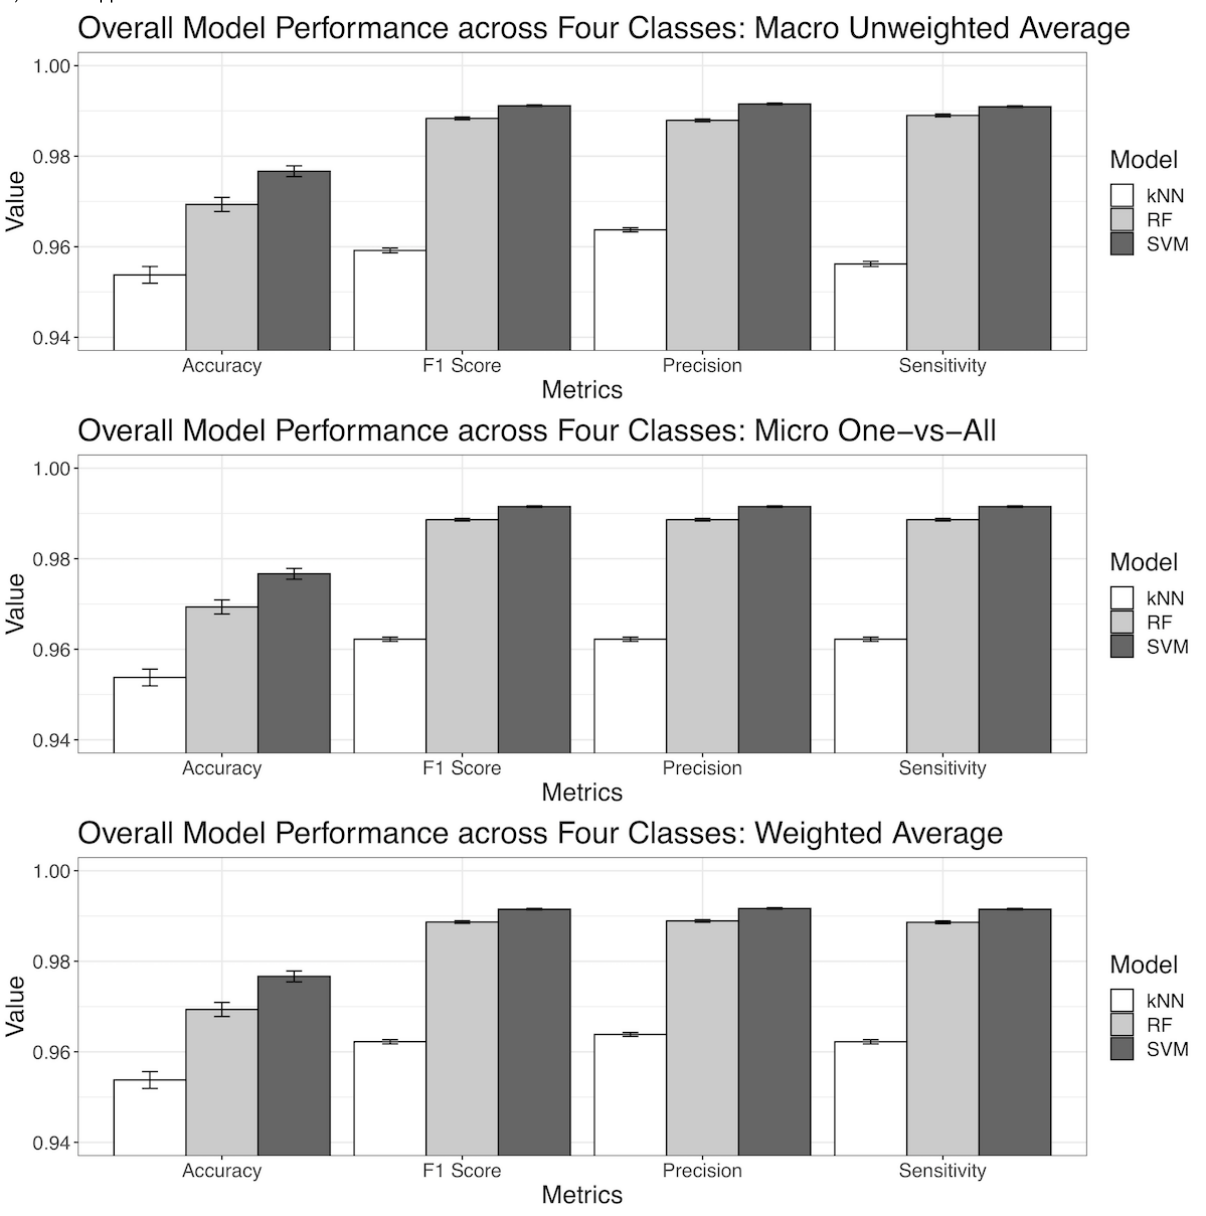
Figure 5. The overall performance of machine learning models across the 4 classes. Model performance was based on the prediction of unseen testing data (ie, the 20% of the original data), not on the 80% of the original data that were used to develop the model. kNN: k nearest neighbor; RF: random forest; SVM: support vector